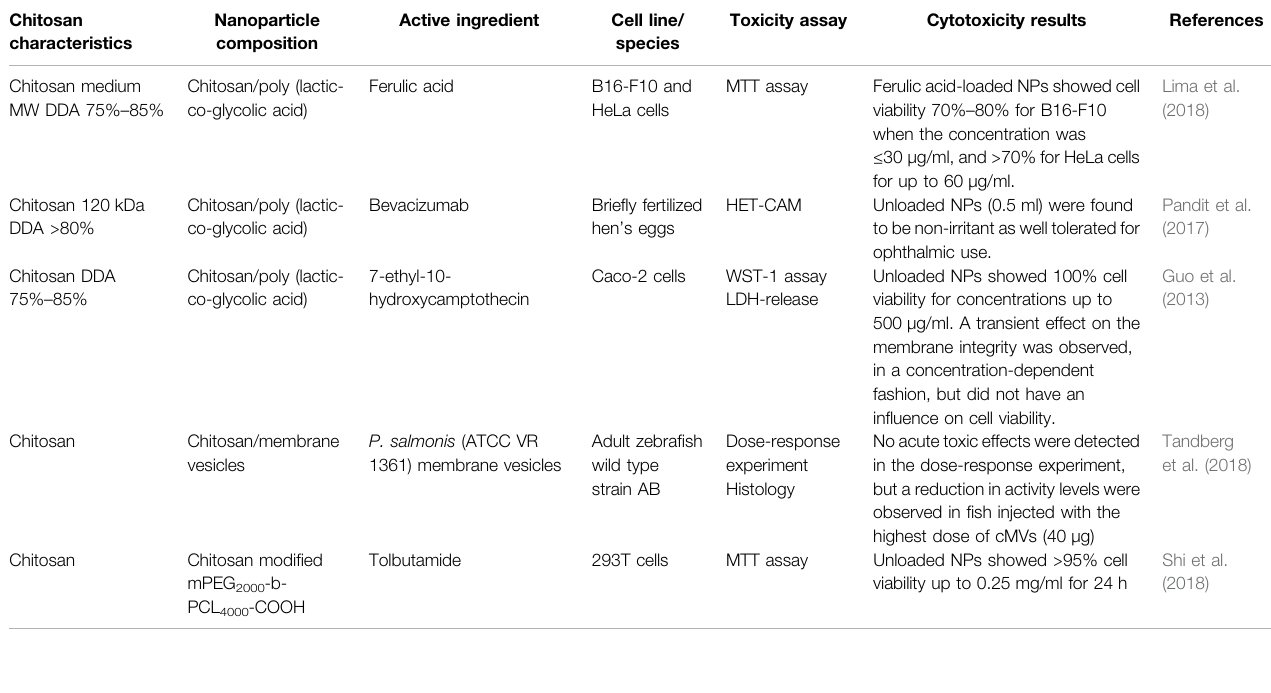
TABLE 4 | Articles on nanoparticles coated with chitosan, main fi ndings.